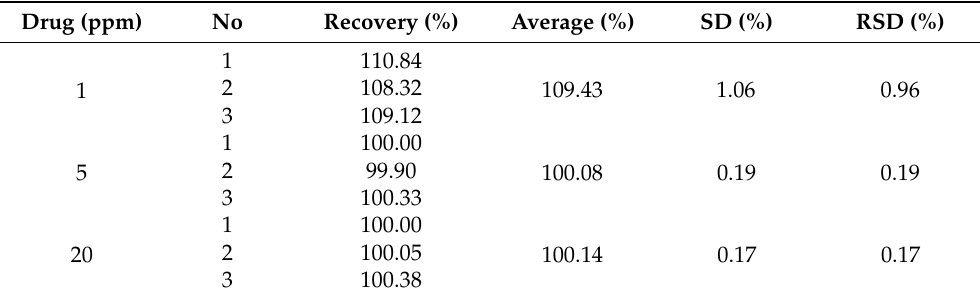
Table 3. Accuracy data obtained from the developed analysis of MPa. Drug